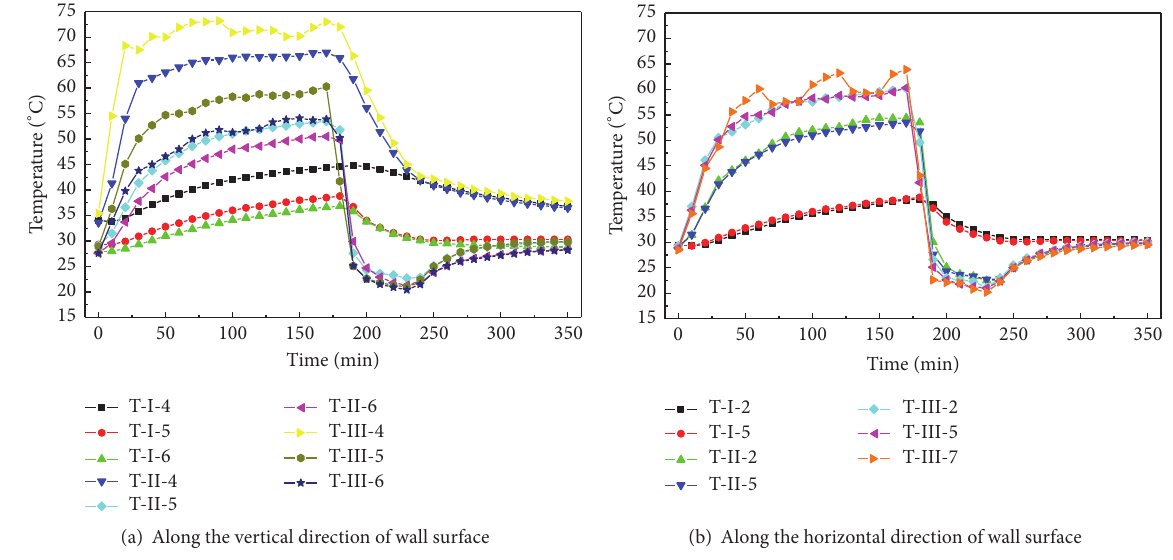
(b) Along the horizontal direction of wall surface Figure 7: Temperature changing curves at various measuring points.